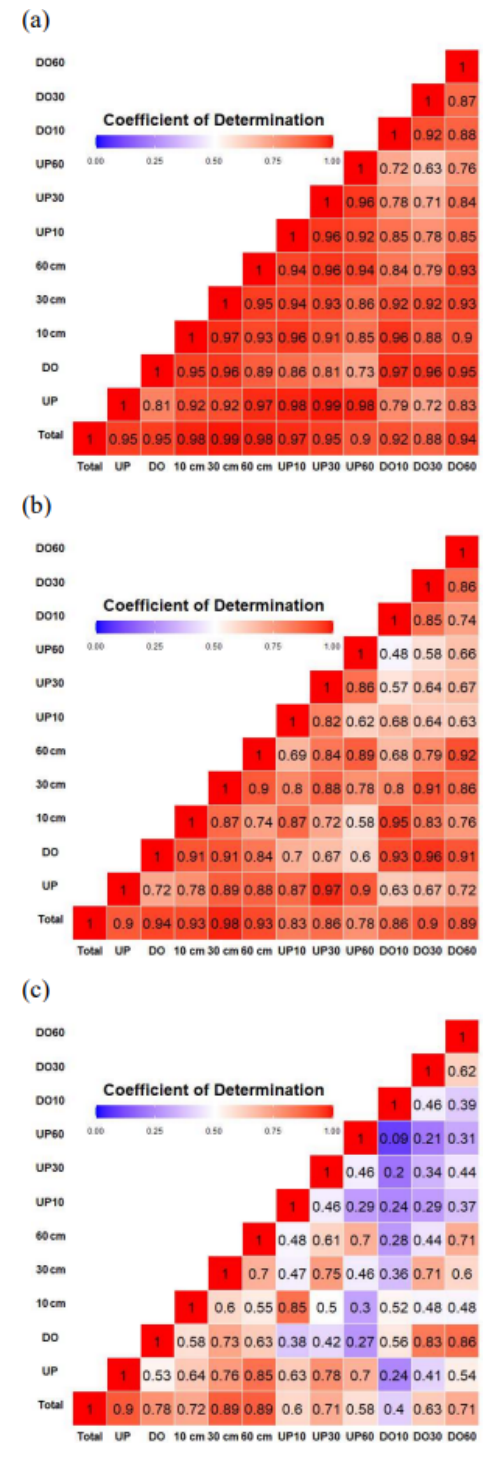
Figure 4. Heat maps depicted for the coefficient of determination ( R 2 ) among combinations of (a) antecedent soil moisture, (b) soil moisture difference index, and (c) standard deviation of peak